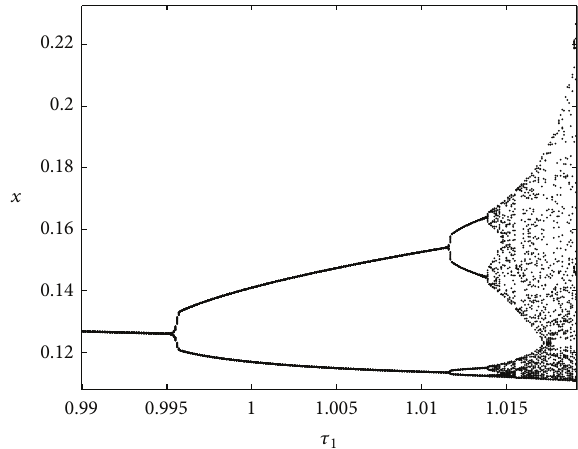
Figure 5: Bifurcation diagram of model (1) showing the effect of 𝜏 1 on the dynamical